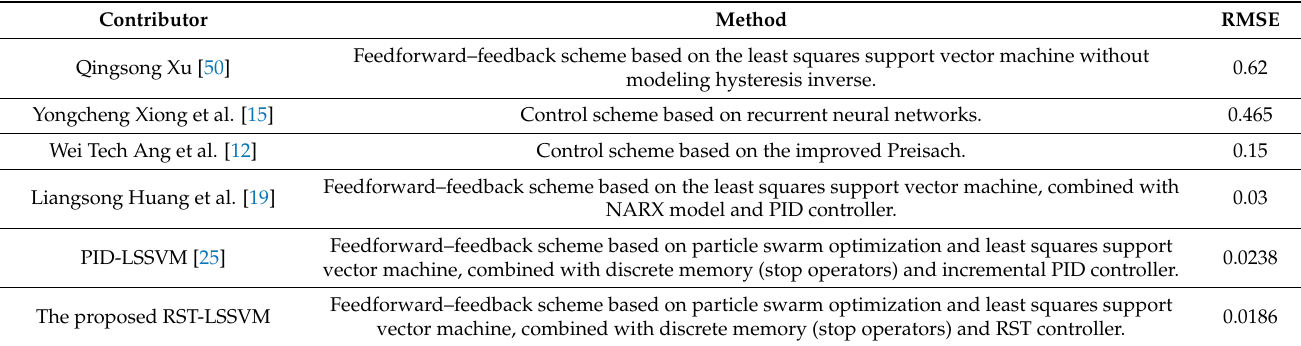
Table 6. Comparison between the proposed method and previous